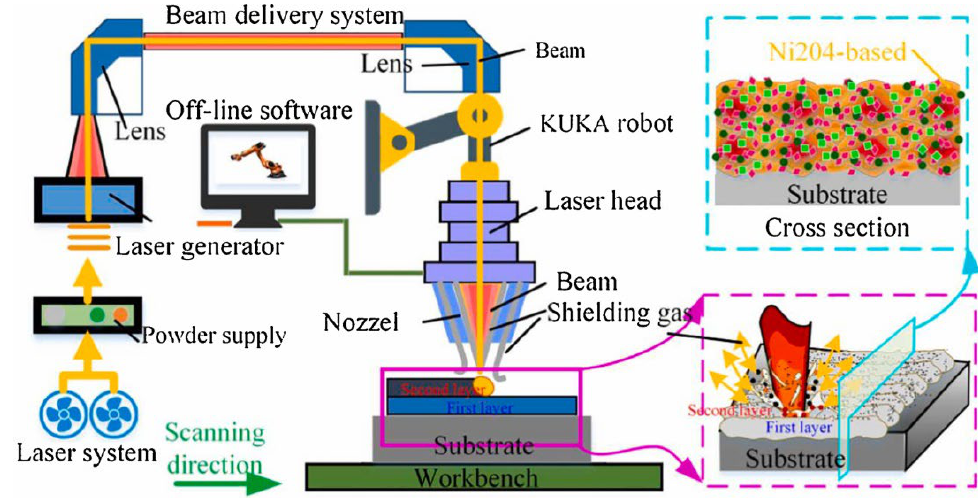
Figure 2. Schematic diagram of the LC system (reprinted from Ref. [61] with the kind permission of Elsevier).